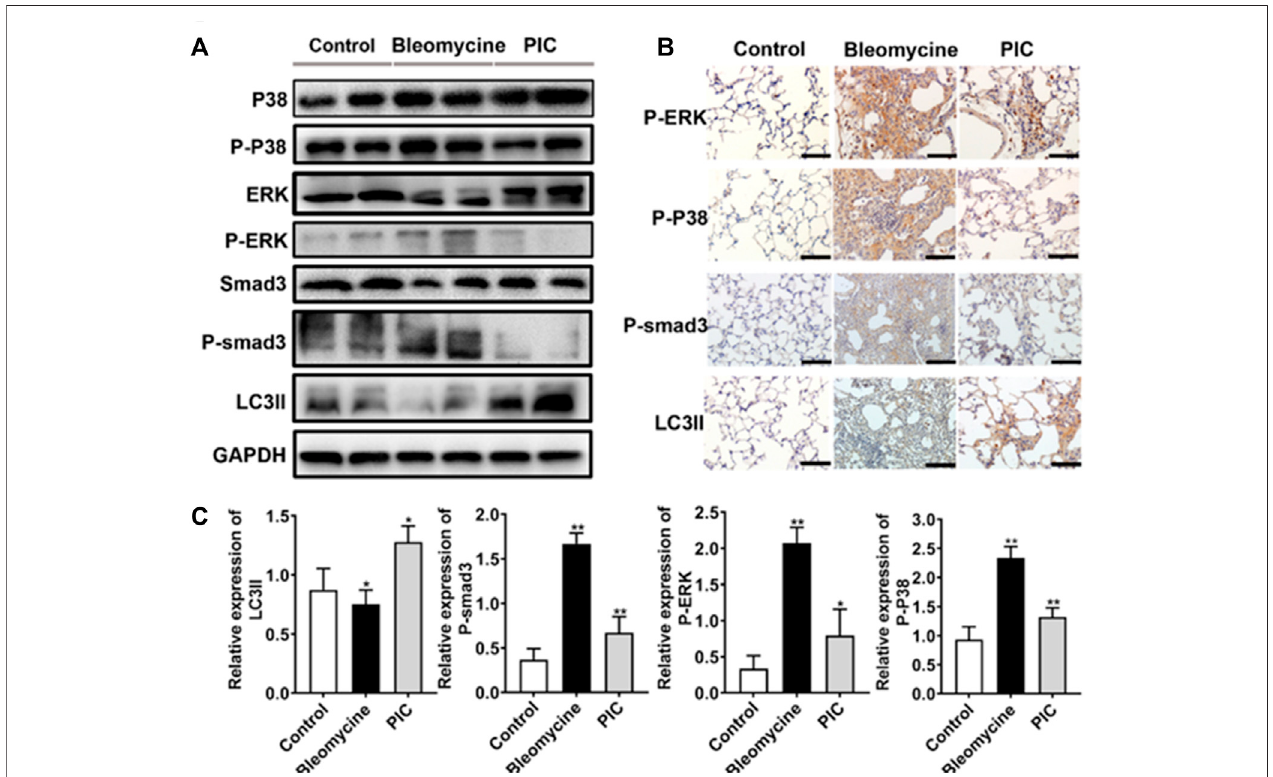
FIGURE 6 | (A) Protein expression of LC3BII, P-Smad3, P-ERK and P-P38 in lung tissues of indicated groups. (B) Immunohistochemical staining of LC3BII, P- Smad3, P-ERK and P-P38 in lung sections of indicated groups. Scale bars, 100 μ m. (C) Quantitative expression analysis of LC3II, P-Smad3, P-ERK and P-P38 in different groups. Data are expressed as mean ± SD, n = 6. * p < 0.05 and ** p <